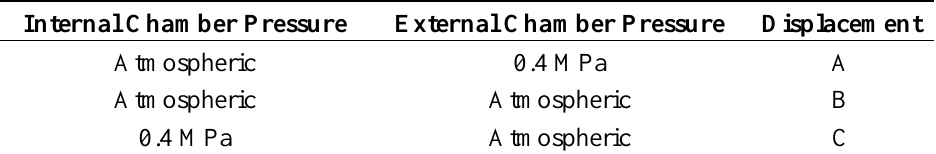
Table 1. Relation between chamber pressures and